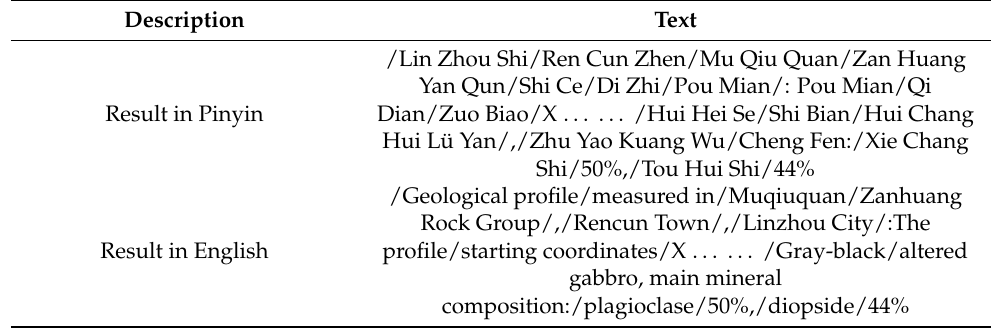
Table 2. Result display of the HCRF algorithm for geological text